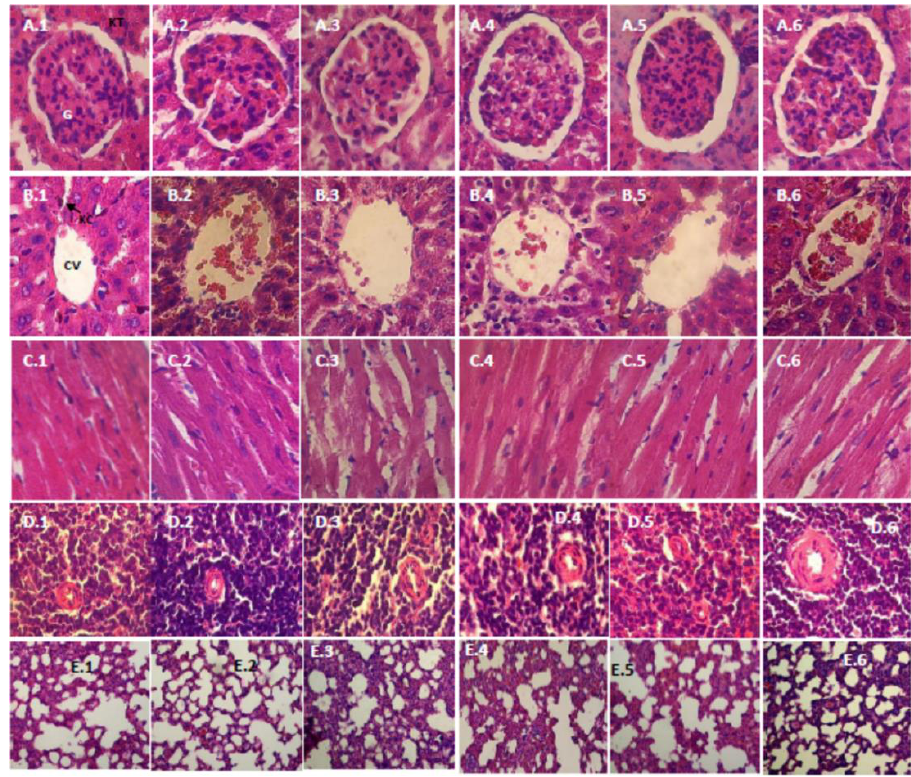
Figure 1. Histopathological examination (HE, 400×) of various organs of male rats in a subchronic oral toxicity study: ( A – E ) the kidney, liver, heart, spleen and lung, respectively; and (1 – 6) the control, satellite-control, the low, middle, and high dose groups, and the satellite-highest dose group (75 mg/kg bw), respectively. G, Glomerulus; KT, Kidney Tubules; CV, Central Vein; KC, Kupffer Cell.